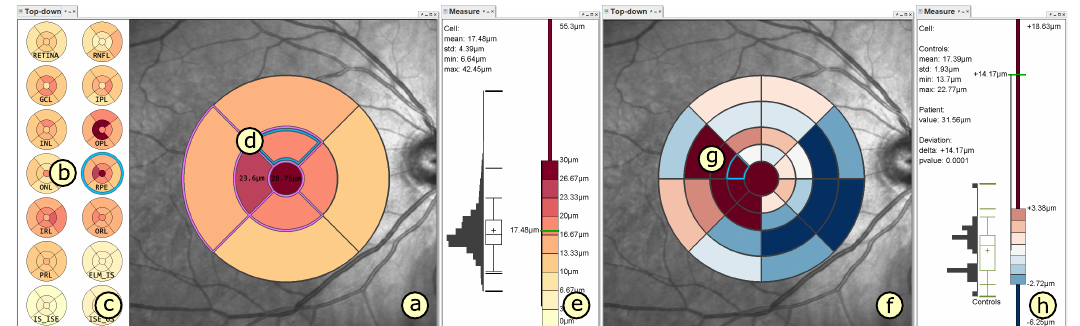
Figure 5. Overview of our visualization design. In the left top-down view ( a ), a retinal layer ( b ) is selected in the layer overview ( c ) and an associated thickness grid is shown on top of a fundus image. Cell color encodes aggregated thickness values, labels indicate cell values close to specified thresholds, and borders of cells with low ratings are highlighted (purple). Details of a selected cell ( d ) are shown in a linked measurement view ( e ). In the right top-down view ( f ), a grid is mapped and compared to a control grid and deviations are color-coded. Details of a selected cell ( g ) are shown in a second measurement view ( h ) in relation to the control